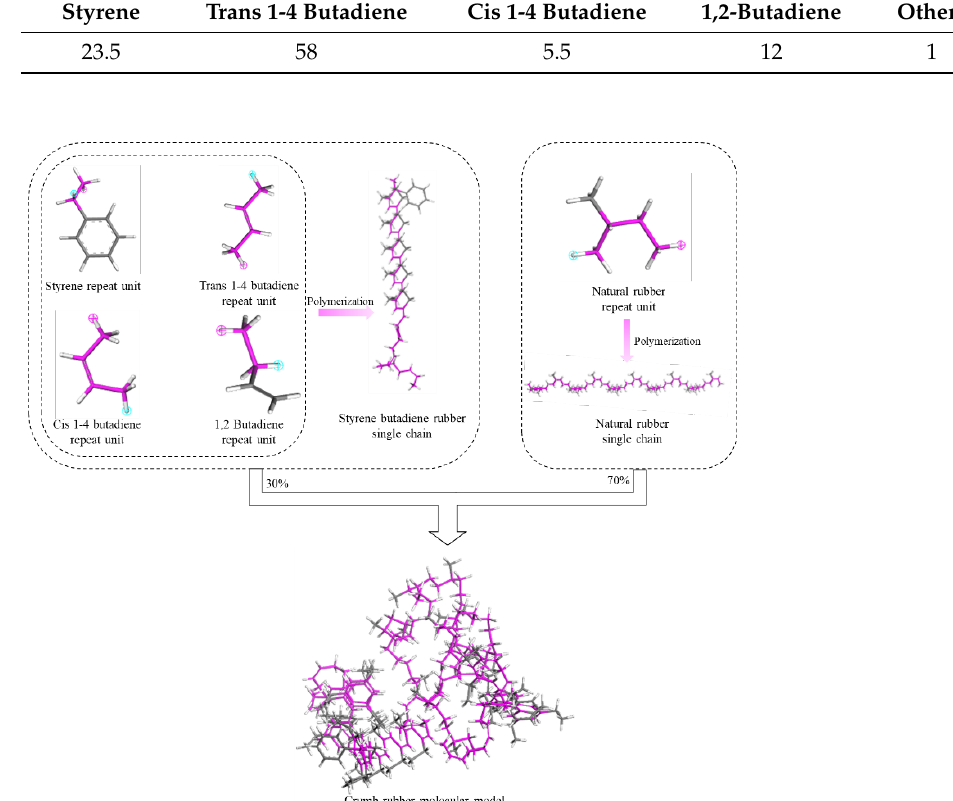
Table 8. Content of styrene butadiene rubber polymer structure repeat unit (w%).